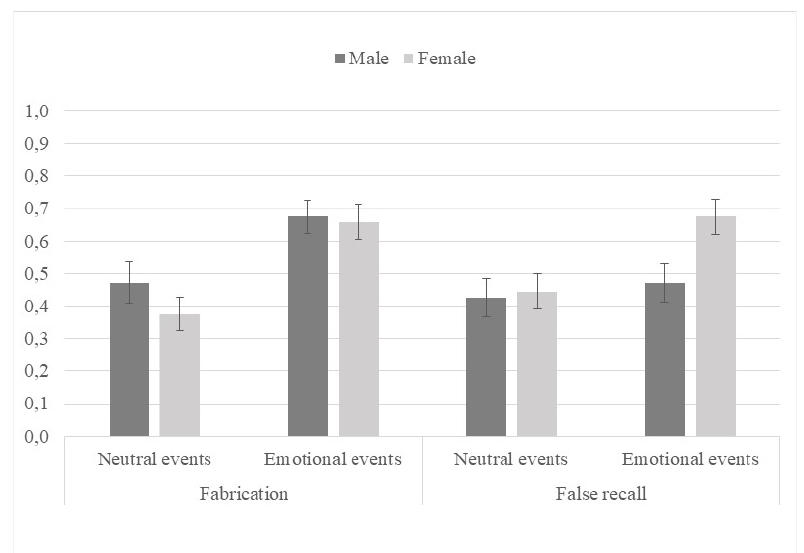
Figure 1. Proportion of fabrication and false recognition (week later) by type of event for men and women. Error bars represent standard error of the mean.